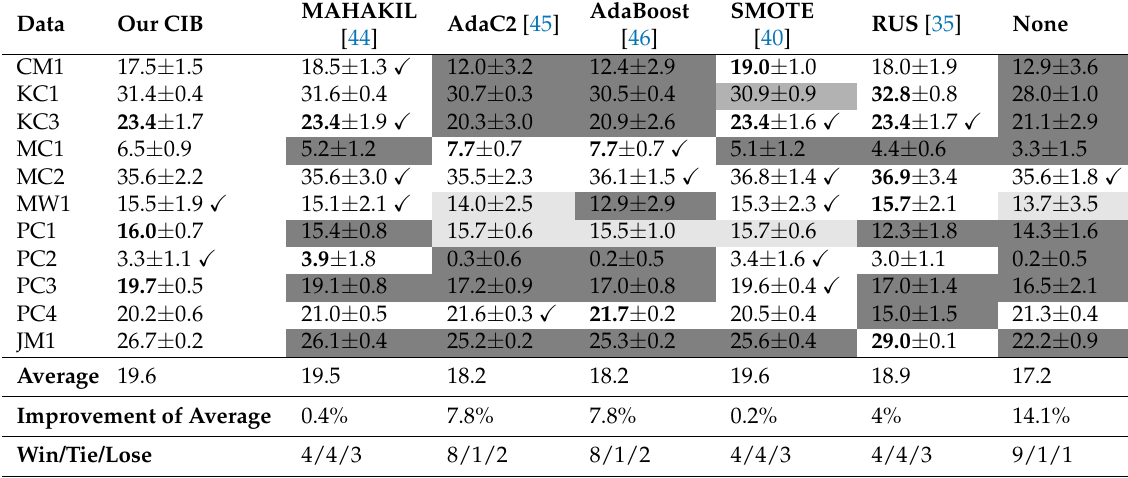
Table 5. The comparison results of AGF for all methods in the form of mean ± standard deviation. The best value is in boldface. Data